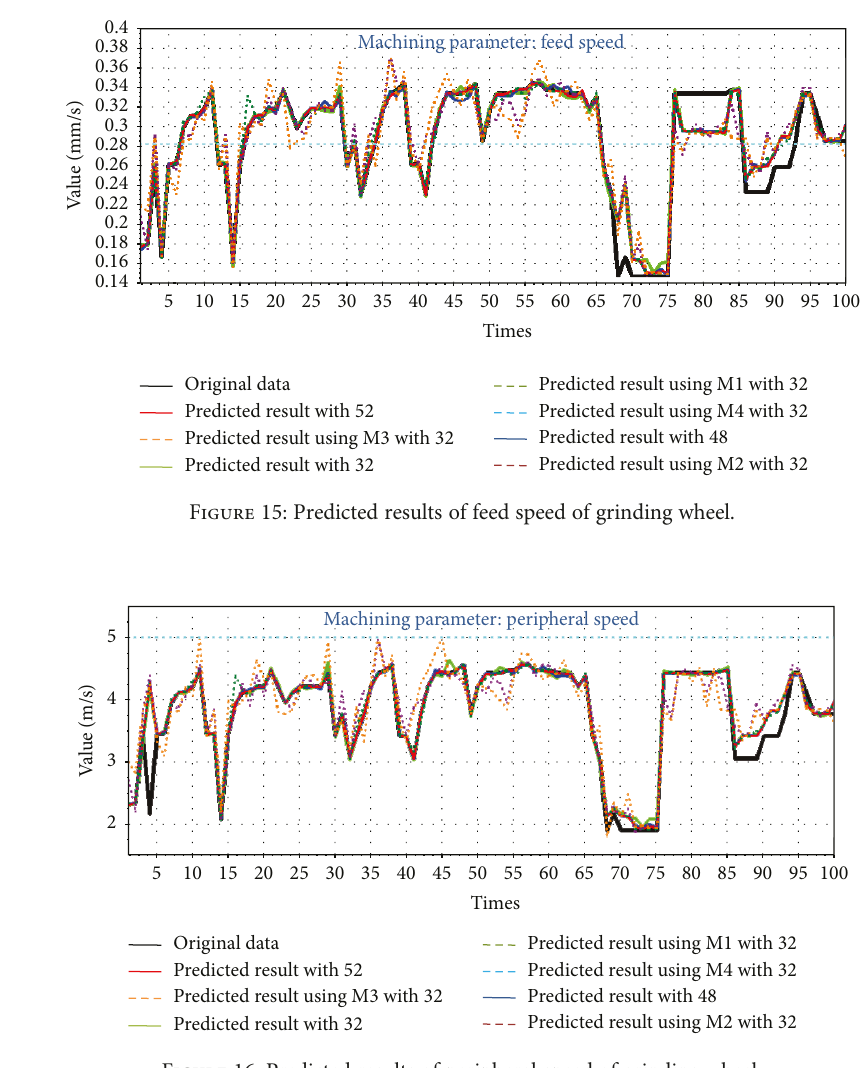
Machining parameter: axial displacement